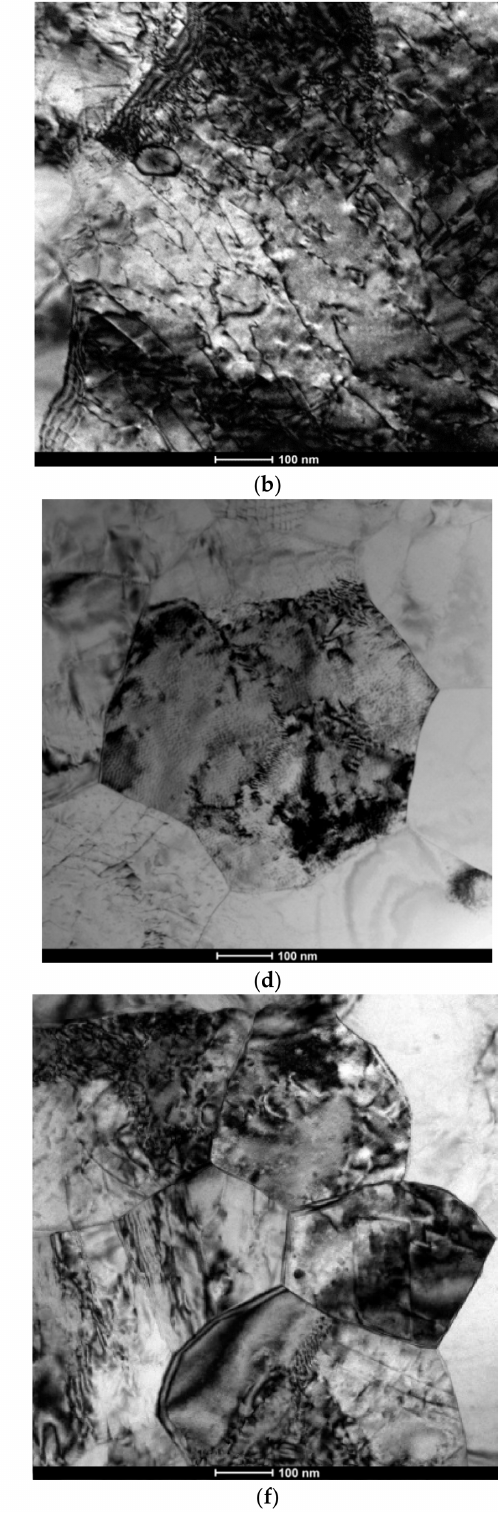
Figure 2. TEM bright-field images of the material in condition: ( a – c ) AR (As-received); ( d ) He720; ( e , f )